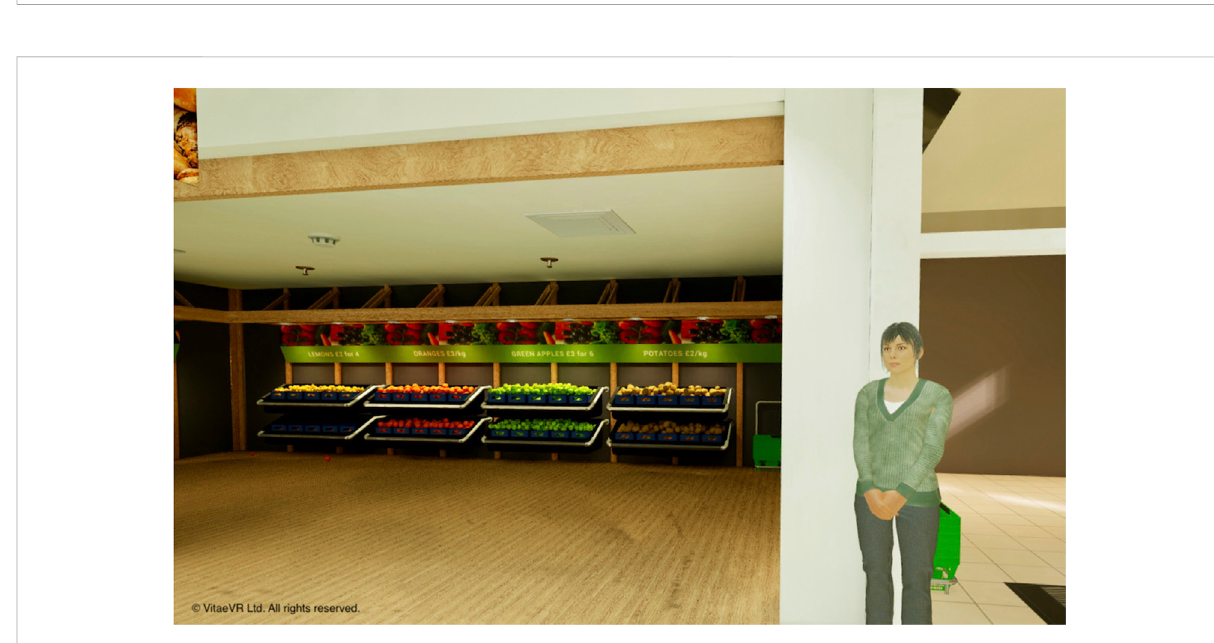
FIGURE 2 VStore fruit and vegetable section and the virtual avatar by the entrance. © Porffy et al. (2022). Originally published in the Journal of Medical Internet Research (https://www.jmir.org), 26.01.2022. This is an open-access article distributed under the terms of the Creative Commons Attribution License (CC BY 4.0). No changes were made in the reproduction of this